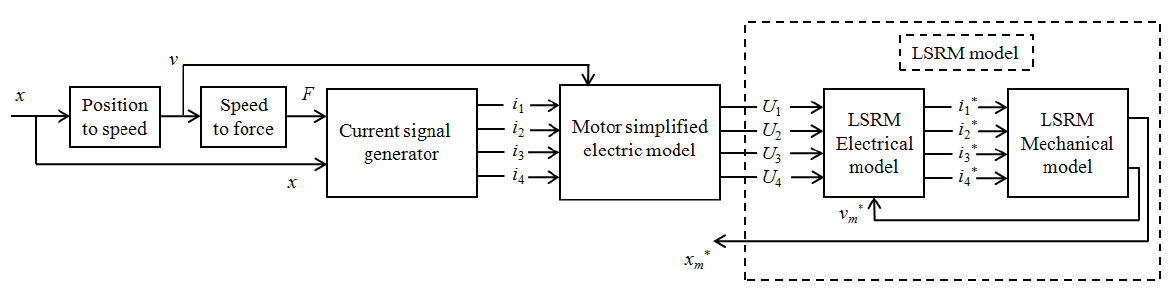
Figure 8. Principle of modeling.